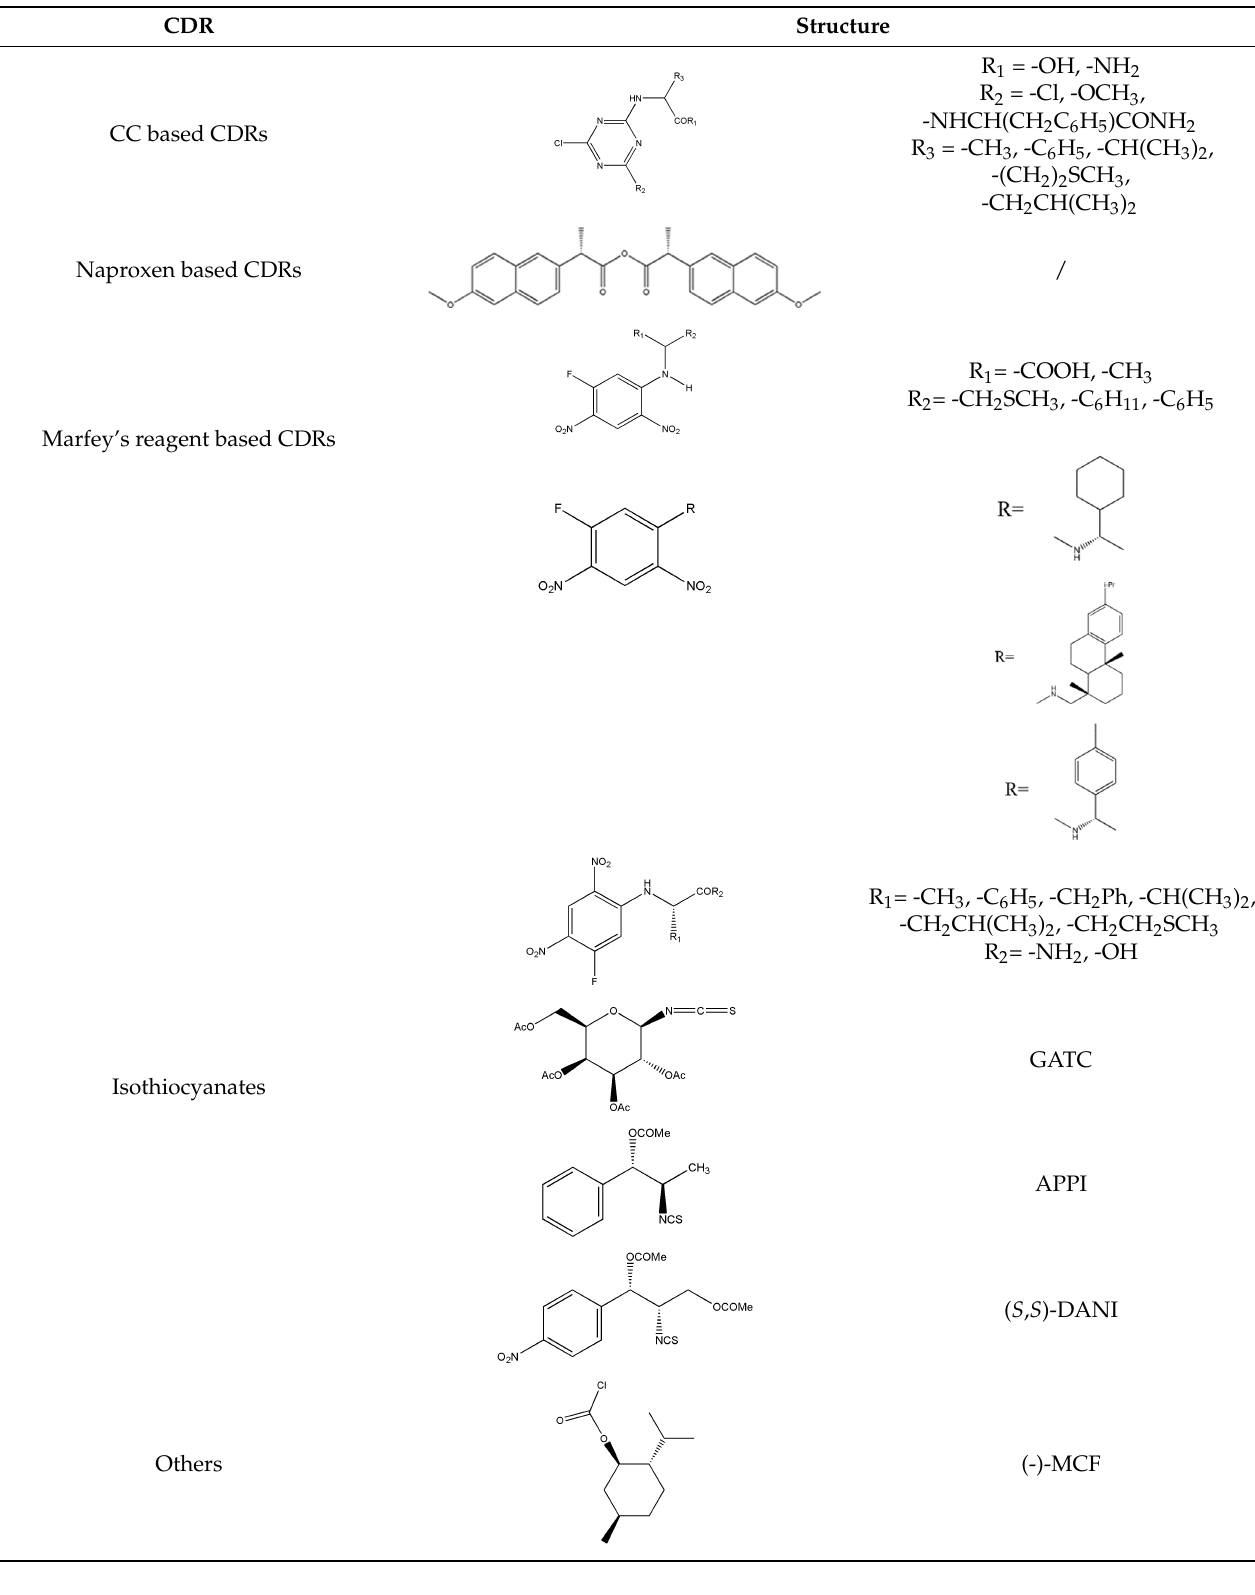
Table 10. Typical chiral derivatization reagents applied to the enantioseparation of β -blockers. CDR